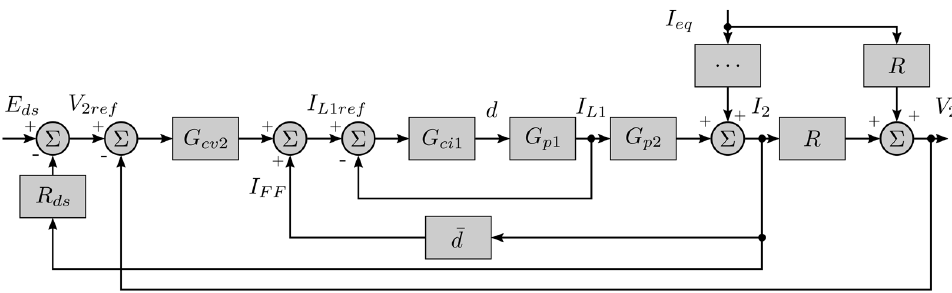
Figure 3. Control scheme used for voltage control of the Split-pi converter in Modes